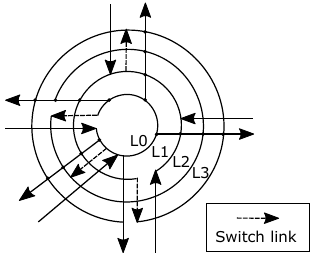
Figure 5. Generated R-NoC topology. L n : Lane